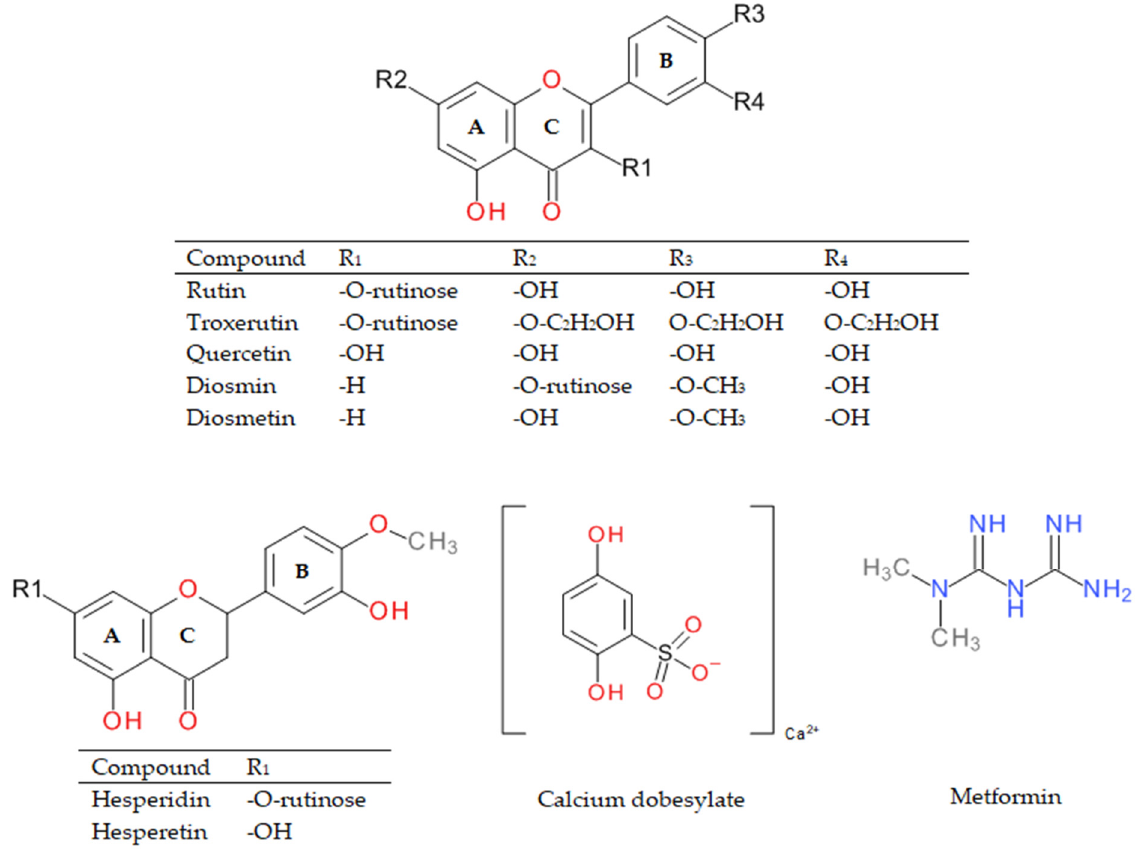
Figure 1. Chemical structures of rutin, quercetin, troxerutin, diosmin, diosmetin, hesperidin, hesperetin, calcium dobesilate, and metformin.